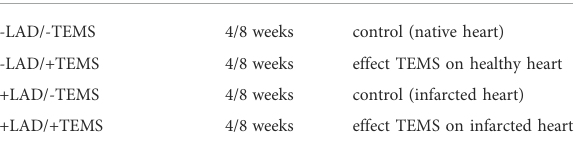
TABLE 1 Experimental groups, timepoints and